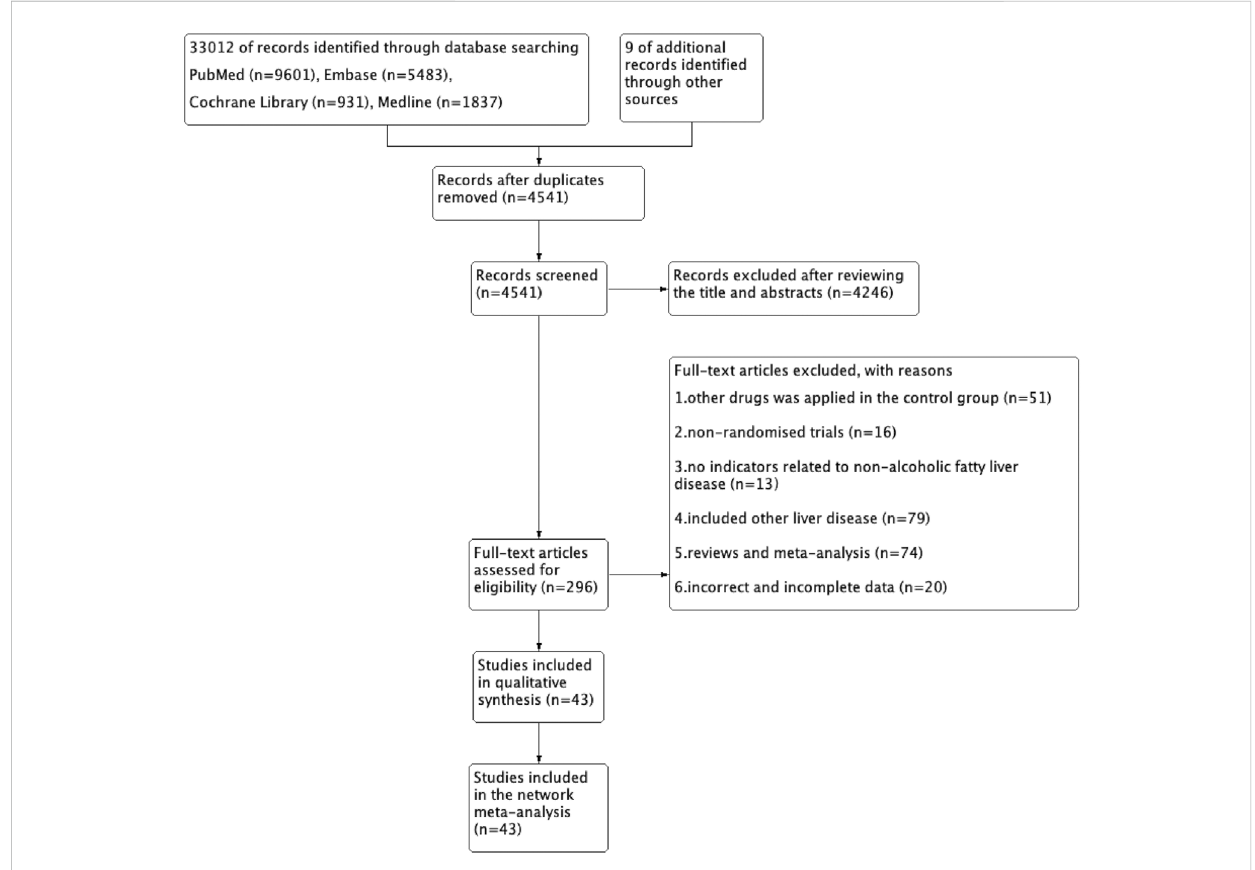
FIGURE 1 Recruitment fl ow chart and study